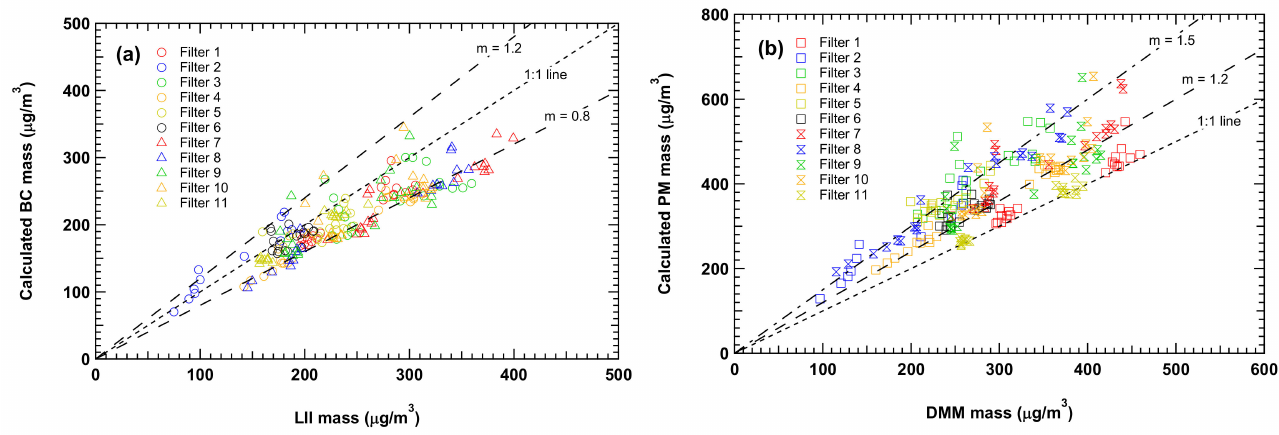
Figure 4. Comparison of the calculated ( a ) BC mass and ( b ) PM mass with the measured